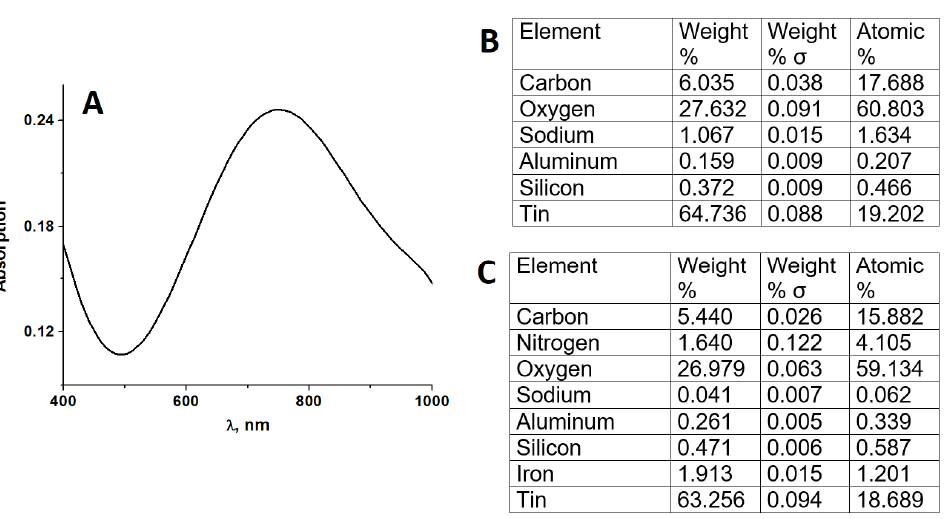
Figure 1. ( A ) optical absorption spectrum of the glass|FTO|PB sensor registered in PBS, ( B ) ele ‐ mental SEM analysis of the glass|FTO electrode, ( C ) elemental SEM analysis of the glass|FTO|PB